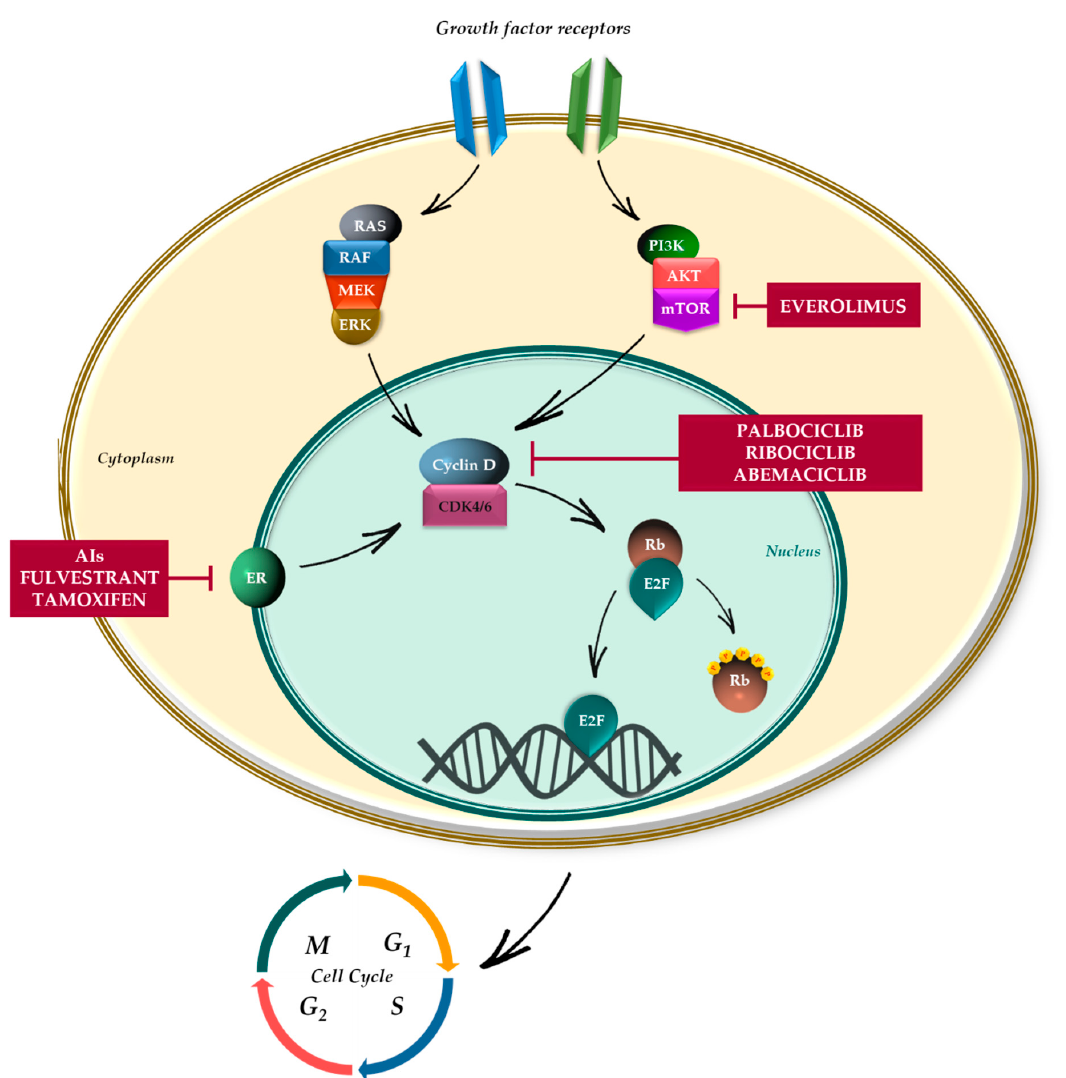
Figure 1. Mechanism of action of CDK4/6 inhibitors. Activation of upstream signaling pathways, such as MAPK, PI3K, and ER, regulate the progression of cell cycle by promoting the formation of complex cyclin D-CDK4/6, which selectively phosphorylates and inactivates pRb protein. Rb proteins limit the expression of many E2F target genes which are involved in cell cycle progression, DNA replication, and mitotic progression. CDK4/6 inhibitors (palbociclib, ribociclib, and abemaciclib) selectively inhibit the downstream CDK4/6-mediated phosphorylation of Rb, leading to cell cycle arrest in G0/G1 phase. Combination strategies are focused on dual blockade of CDK4/6 and upstream signaling, mainly mediated by ER, MAPK pathway and PI3K/AKT/mTOR pathway.